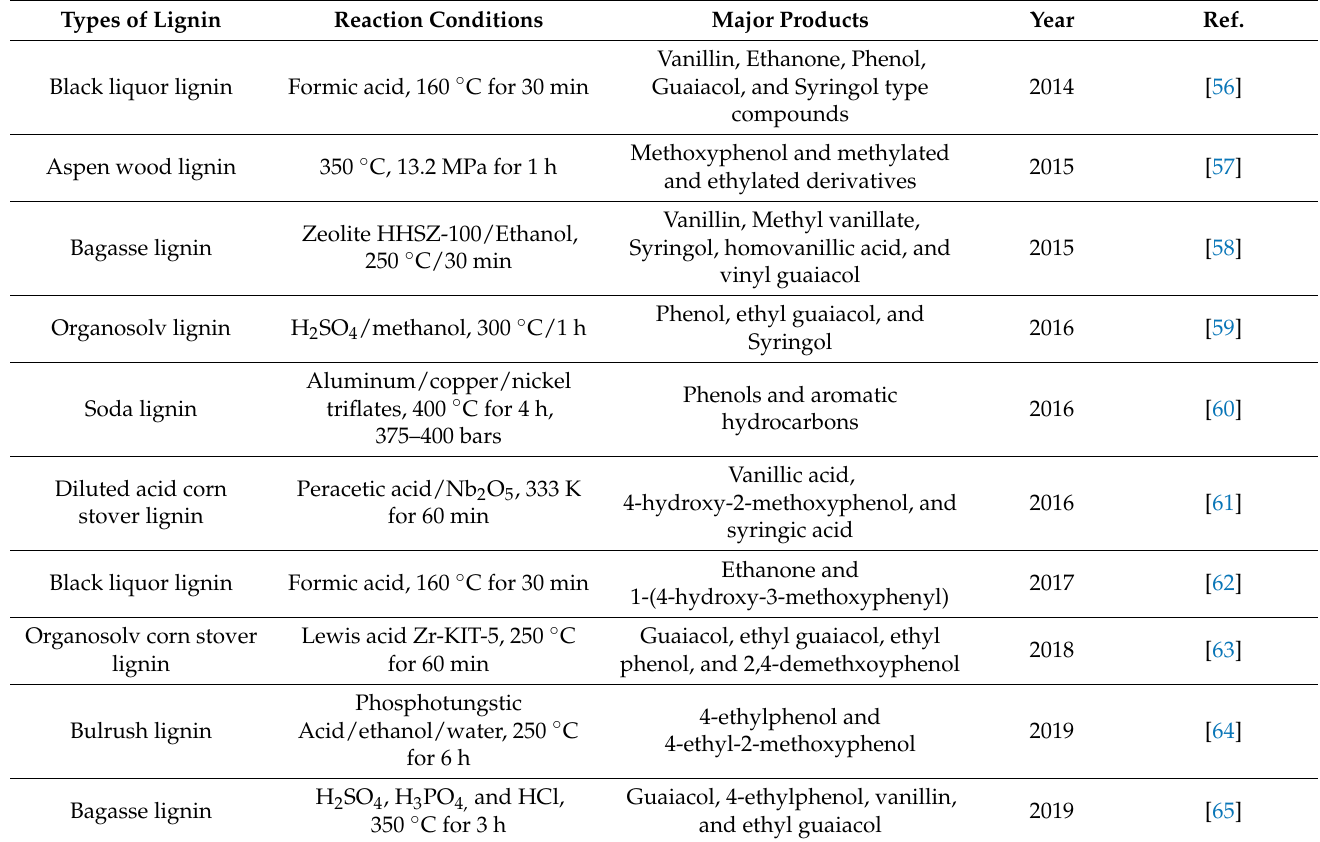
Table 2. Acid-catalyzed depolymerization of